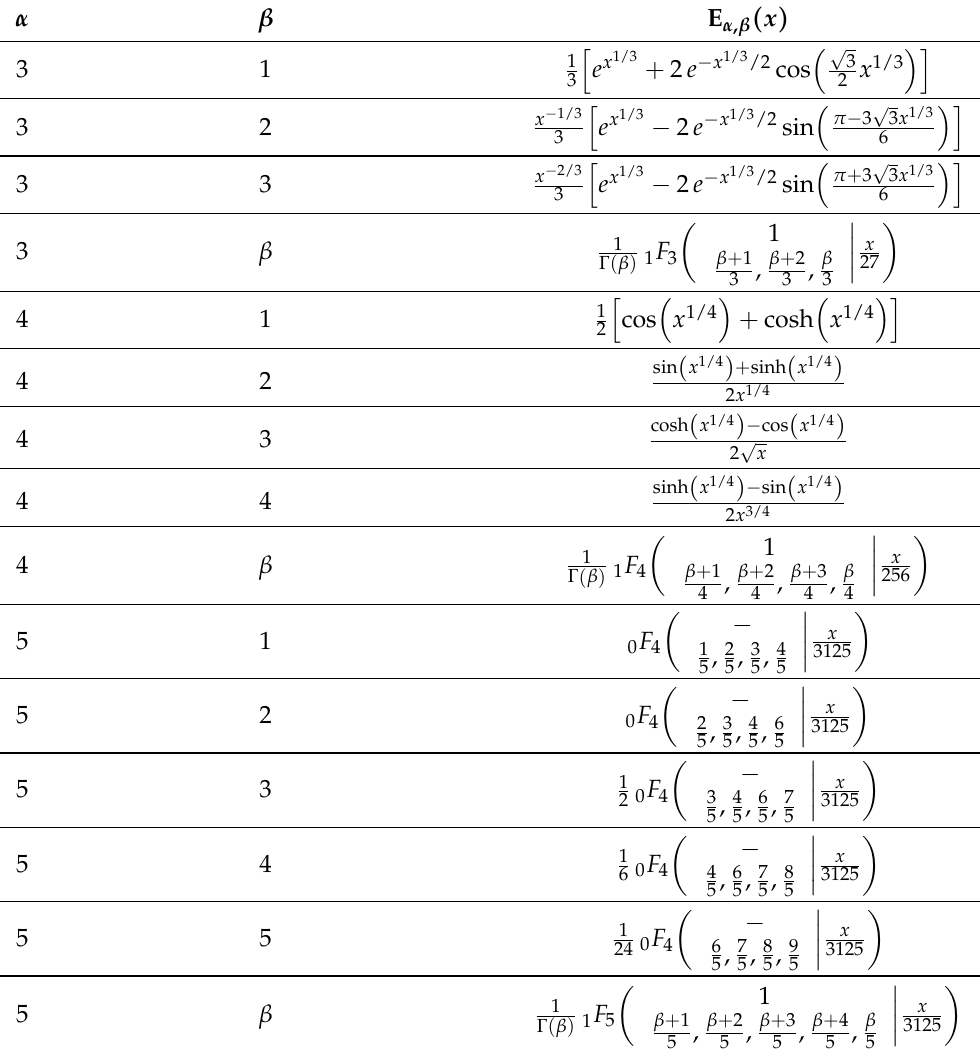
Table A2. The Mittag-Leffler functions derived for some values of parameters α and β by using (9).